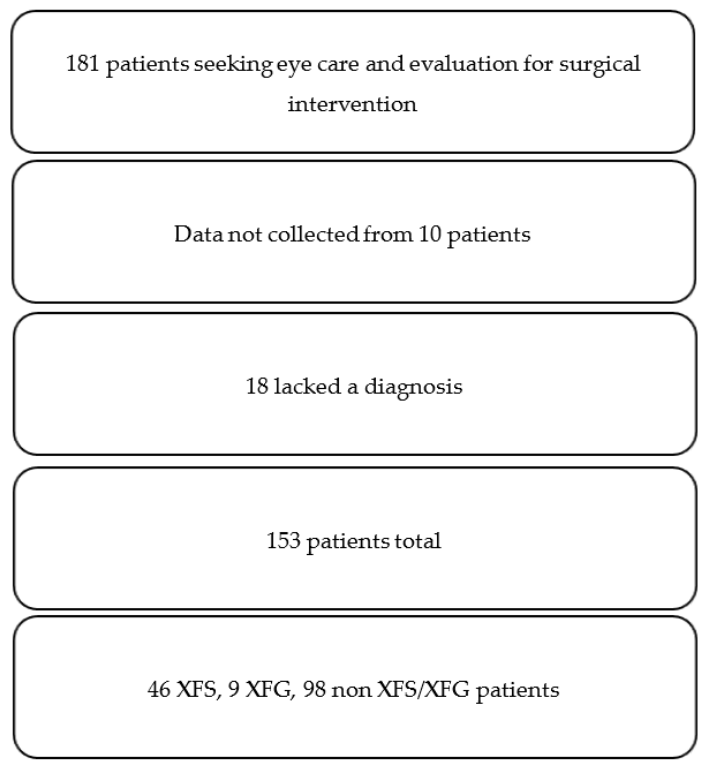
Figure 2. Study Flowchart. Table 2. Multivariable regression model comparing demographics among XFS/XFG vs. non XFS/XFG